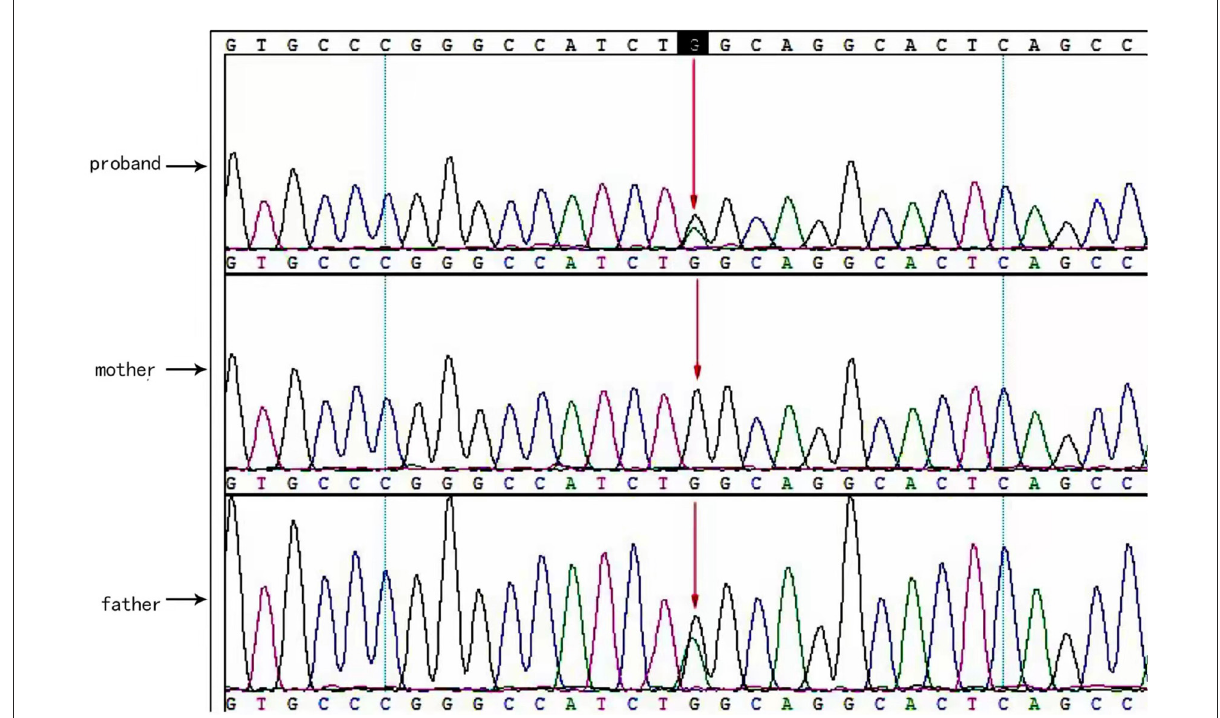
FIGURE1 ABCC8 gene c.863G > A mutated sequence in the proband. Arrows indicate the mutation